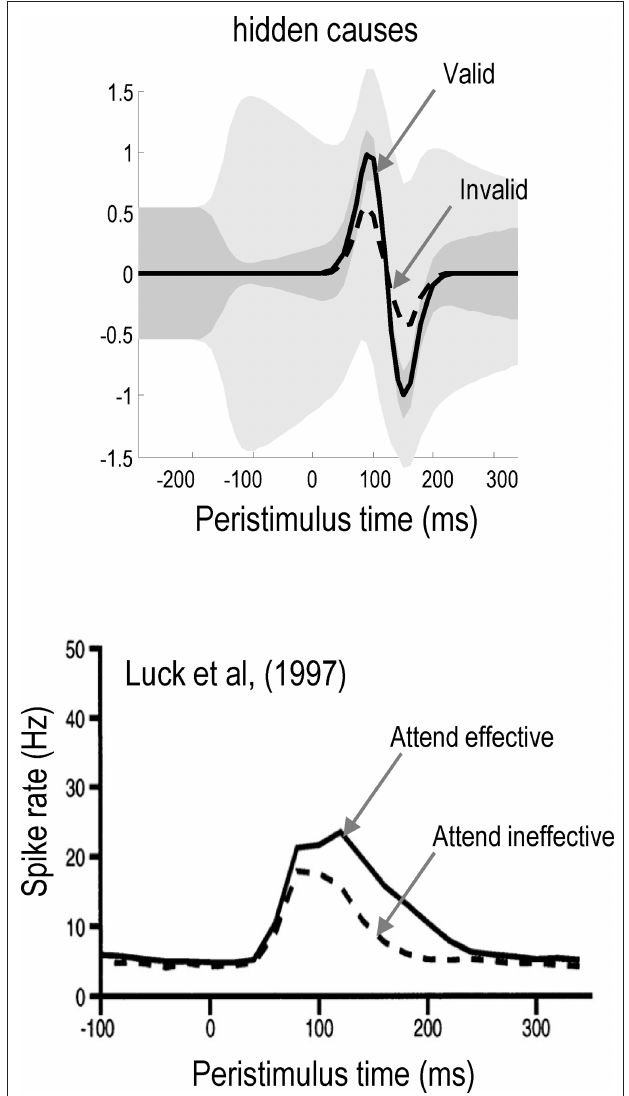
Figure 8 | This figure demonstrates how generalized predictive coding reproduces some quantitative aspects of biased competition. The simulation (upper panel) reproduces the conditional expectations in the previous figure about valid (solid line) and invalid (dashed line) targets, when presented simultaneously. These two responses resemble those reported in Luck et al. (1997). Lower panel: peristimulus histograms (over 20 ms bins) redrawn from Luck et al. (1997), following simultaneous presentation of two (effective and ineffective) stimuli averaged over 29 V4 neurons that showed a significant attention effect. The solid line reports trials in which attention was directed to the effective stimulus (cf, responses to a valid target) and the dashed line when attention was directed to the ineffective stimulus (cf, responses to an invalid target). Note that the empirical data are non-negative spike counts, whereas the simulated activity represent firing rate deviations around baseline